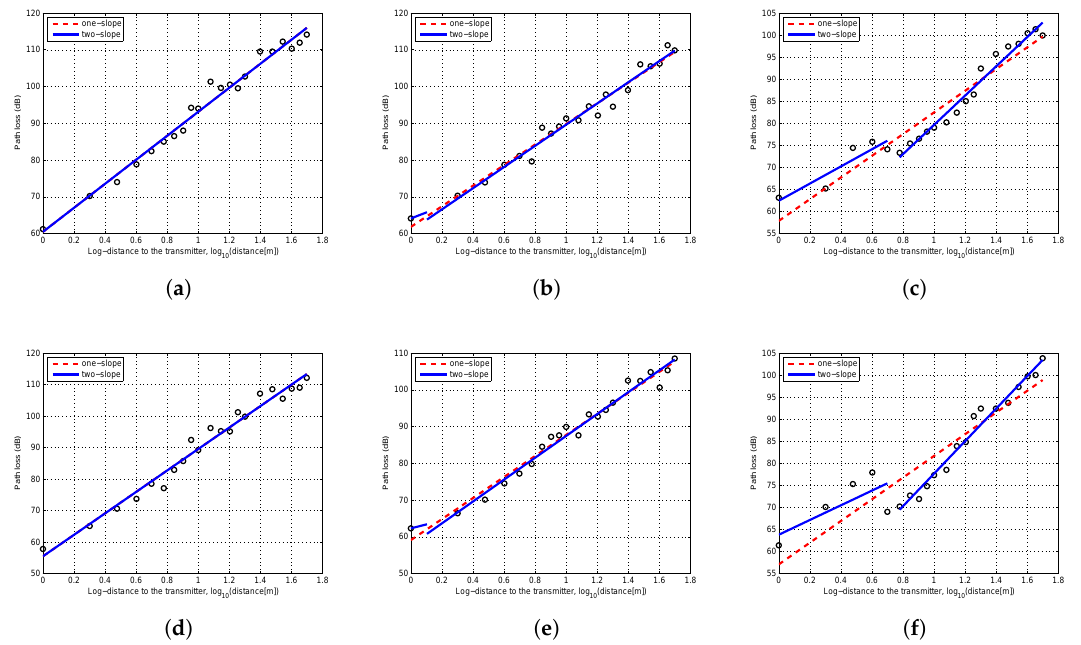
Figure 3. Least squares fitting of measurement results: ( a ) flat concrete road, H t = H r = 5 cm; ( b ) flat concrete road, H t = H r = 50 cm; ( c ) flat concrete road, H t = H r = 1 m; ( d ) flat grass, H t = H r = 5 cm; ( e ) flat grass, H t = H r = 50 cm; and ( f ) flat grass, H t = H r = 1